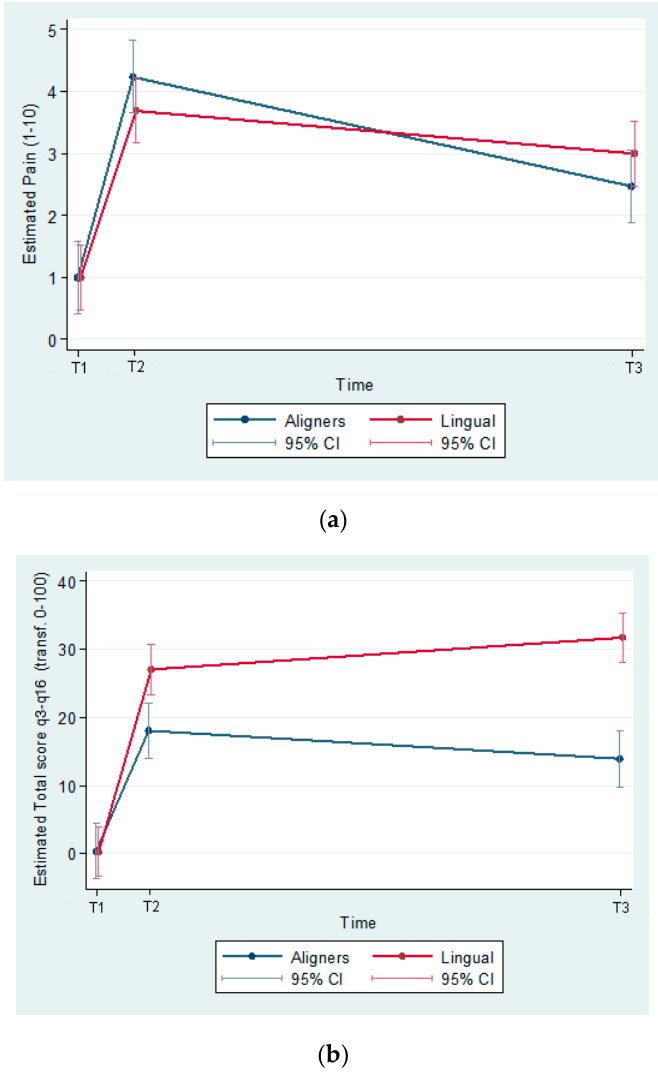
Figure 3. ( a ) Predicted pain (1–10) by group and time (T1, baseline; T2, the first day following ap- pliance insertion; T3, after 3 months). ( b ) Predicted total score Q3–16 (transf. 0–100) by group and time.